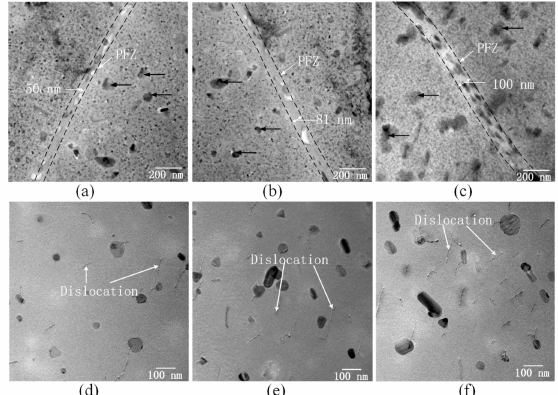
Figure 4. TEM microstructure of 7075 aluminum alloy at di ff erent prebending radii. ( a,d ) 1500 mm; ( b,e ) 1000 mm; ( c,f ) 500